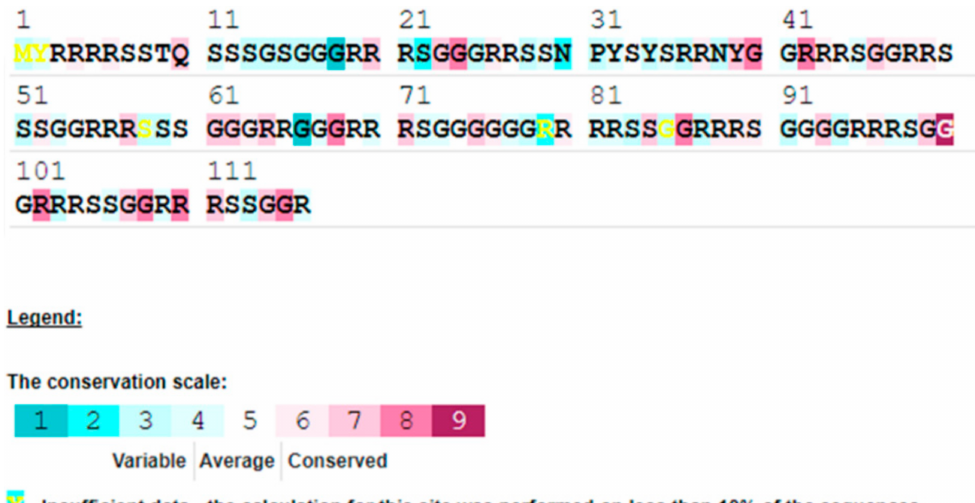
Figure 4. Conserved sites of P6.9 protein of